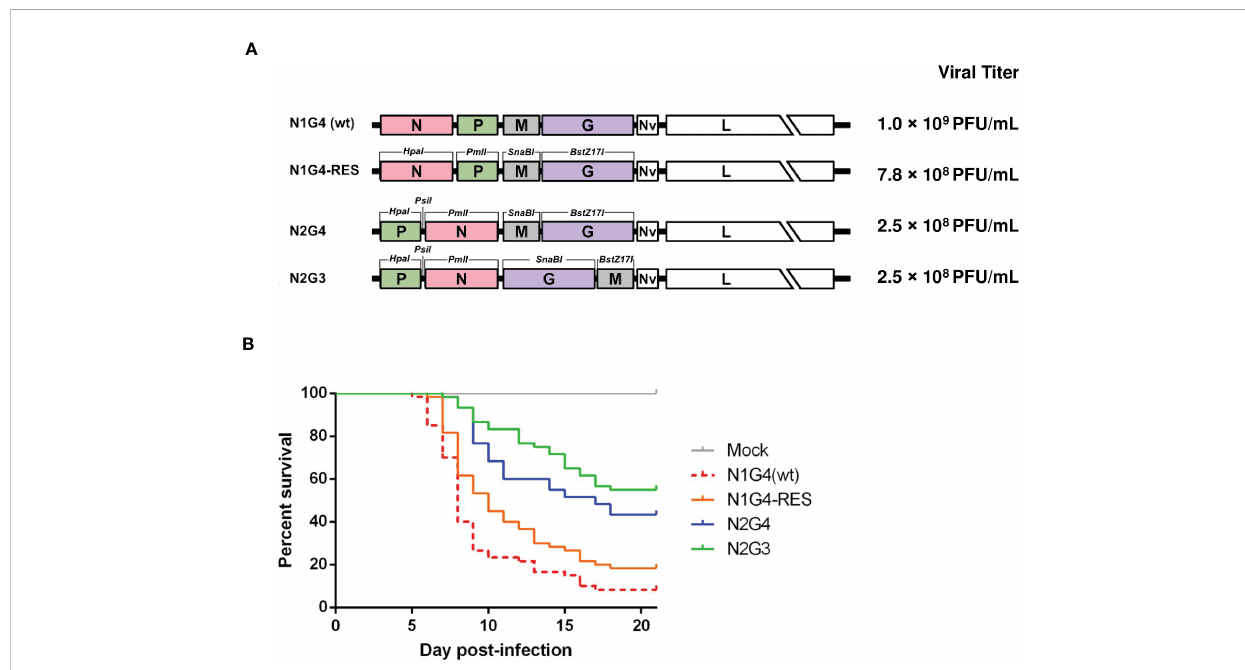
FIGURE 4 VHSV genome rearrangement. (A) Schematic representation of the engineered rVHSV genomes with rearranged gene order. Restriction enzyme sites inserted by site-directed mutagenesis at the beginning and the end of the N, P, M, G and NV ORF are indicated on the N1G4-RES genome. (B) INRA synthetic strain virus-free juvenile rainbow trout (n = 50 per group, mean weight 1.8 g) were infected by bath immersion with rVHSVs as indicated ( fi nal titer, 5 × 10 4 PFU/mL) for 2 h at 10°C. Mortality rates were recorded daily and is presented as percent of